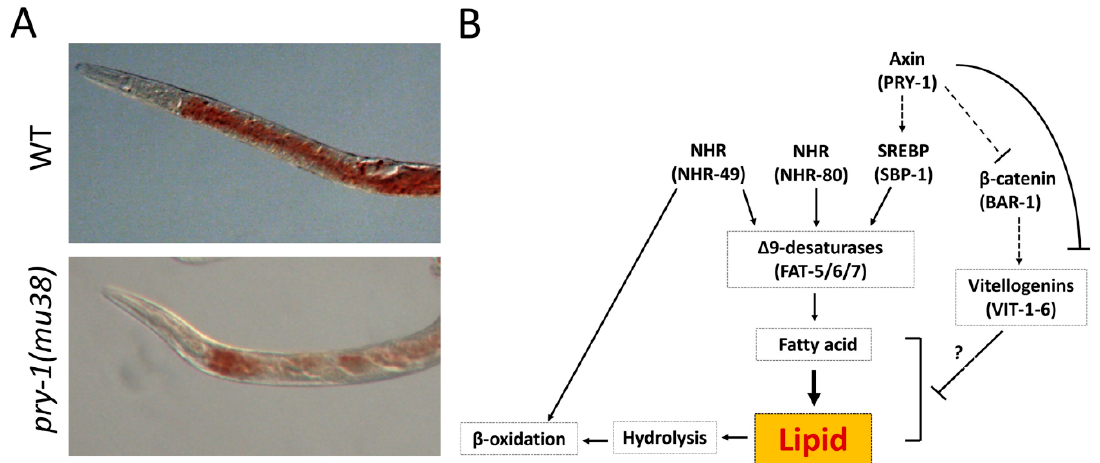
Figure 8. pry-1 is necessary to regulate lipid metabolism. ( A ) pry-1 mutant animals show reduced lipid content compared to wild-type (WT) animals as revealed by Oil Red O staining. ( B ) A model for pry-1 genetic network in regulating lipid synthesis based on findings presented in [86]. pry-1 acts upstream of sbp-1 and in parallel to nhr-49 and nhr-80 . pry-1 also regulates the expression of vit genes. Whether bar-1 participates in this process (dotted connecting lines) and how vits affect lipid synthesis (question mark) are currently not understood.